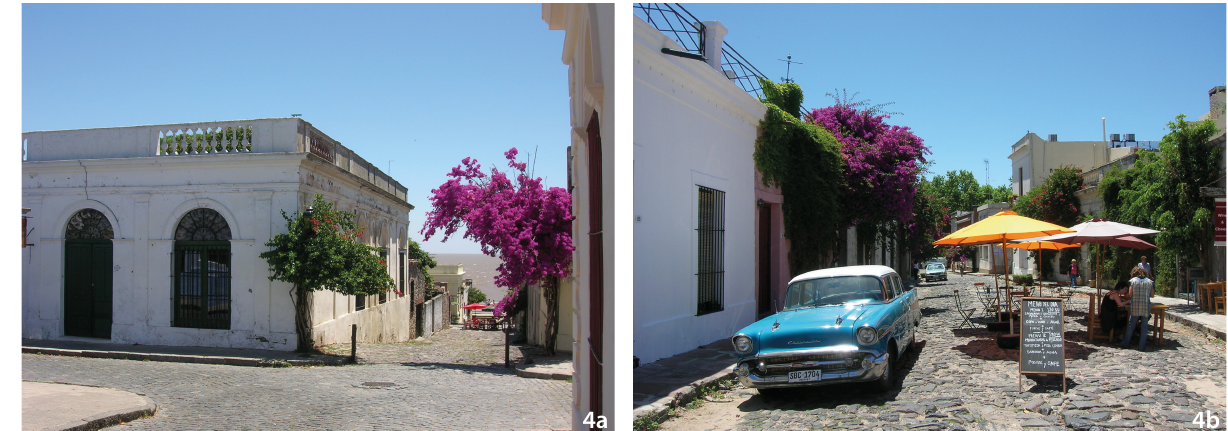
Figure 4a and 4b Colonia del Sacramento, Uruguay, 2005. The gentrification of the colonial historic centre, with the opening of restaurants and hotels, which is very common in colonial cities of South America (Source: the author).